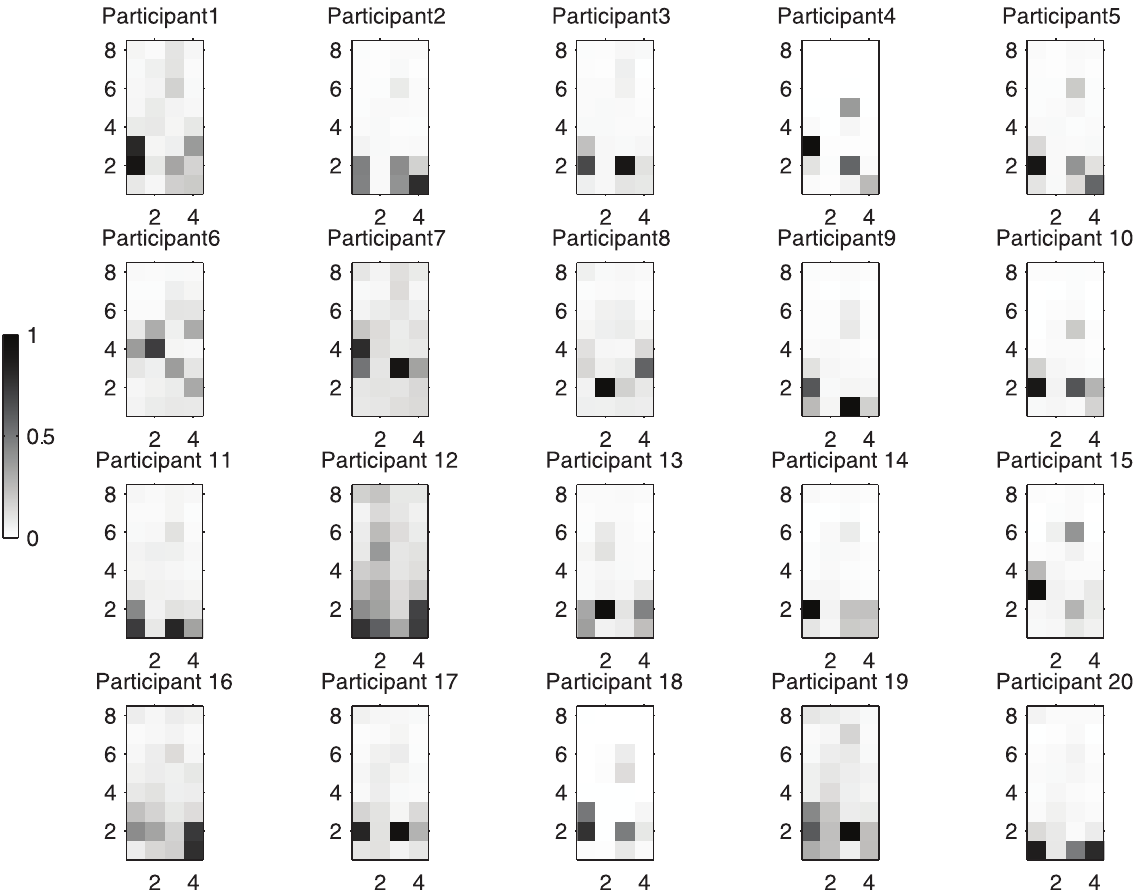
Figure 4. Mean grip shape images of the 20 participants. Each grip shape image represents the grip force distribution on the 4 by 8 force sensor array with the black points being the ones with the highest force.